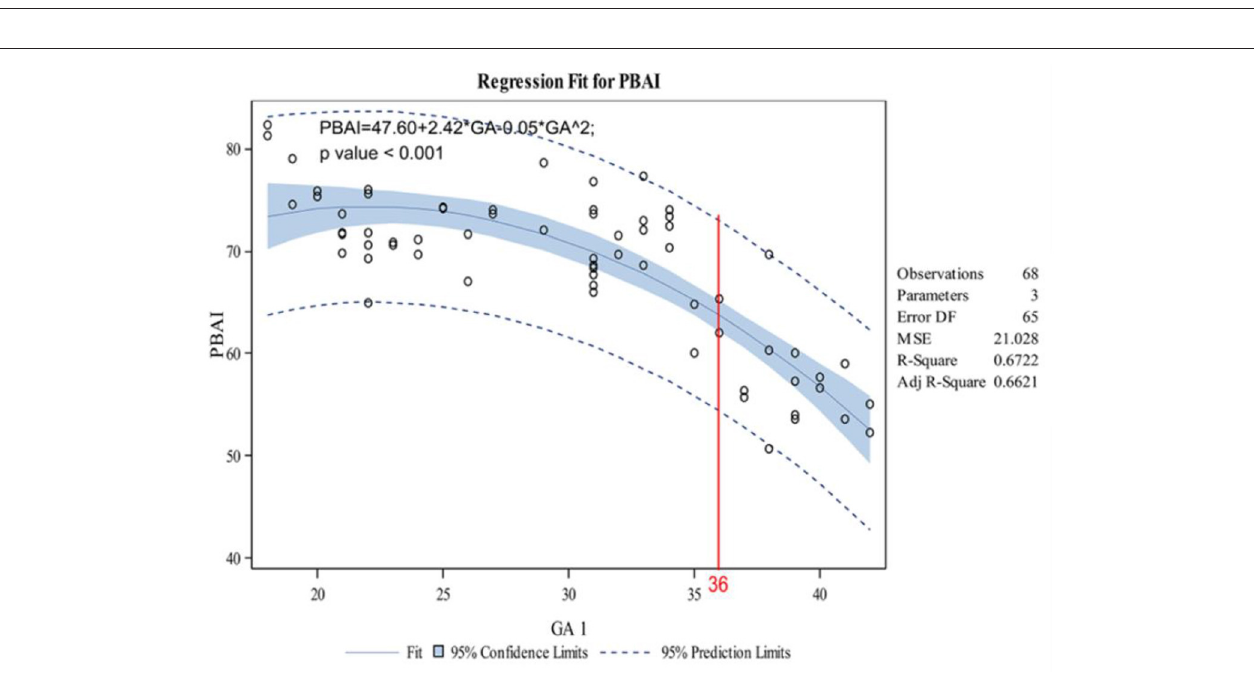
FIGURE 7 | Correlation between gestational age and posterior bony acetabular